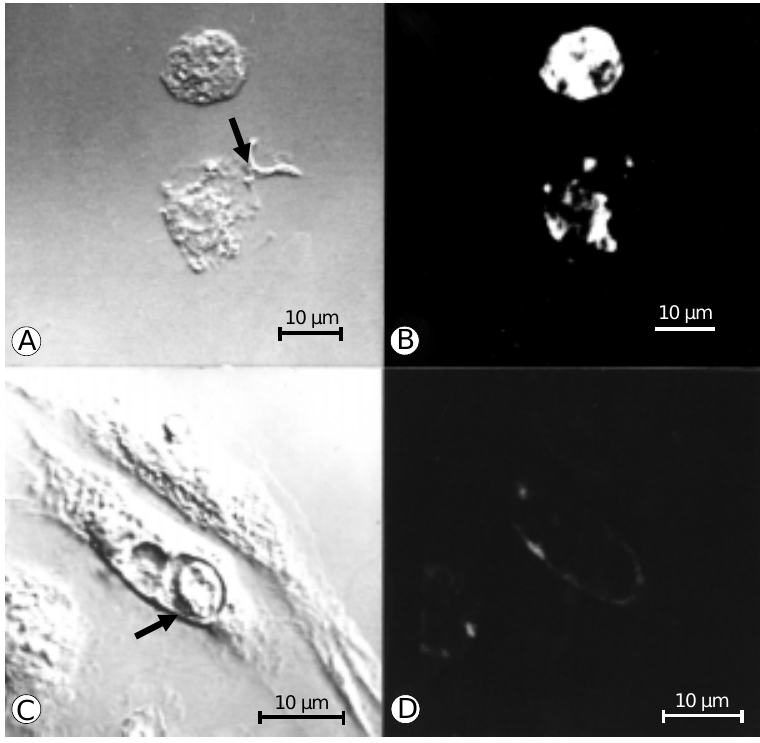
Figure 6 - Labeling of the cell with FITC-thiosemicarbazide and observation by differential interference microscopy (A,C) and CLSM (B,D) following interaction with the trypomasti- gote form of Trypanosoma cruzi. Labeling of the region of adhesion (arrow in A) and within the vacuole (arrow in C) is observed. Bar = 10